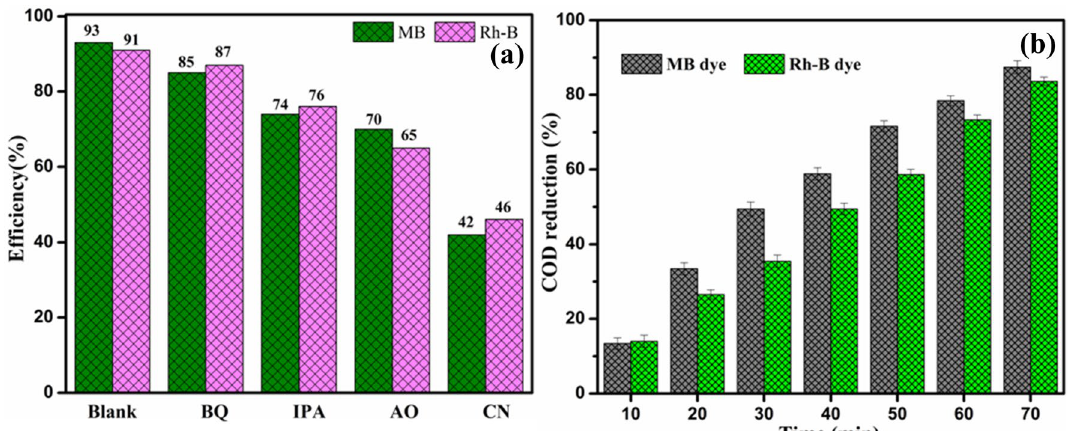
Fig. 15 a Scavenger study b COD